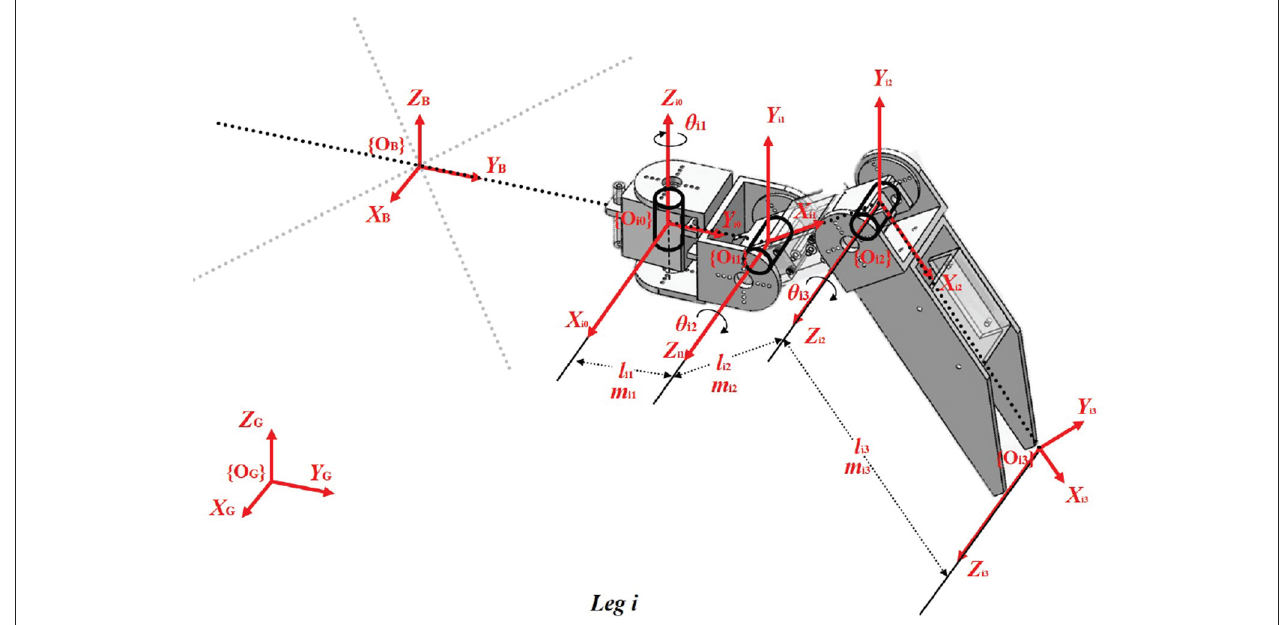
O G denotes the global coordinate, and { }